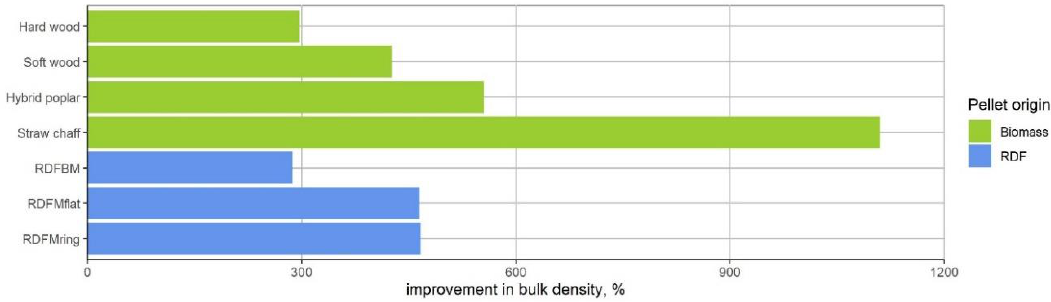
Figure 18. Improvement in bulk densities (related to raw material) of RFD samples, in connection to literature, respectively [32,36,61]